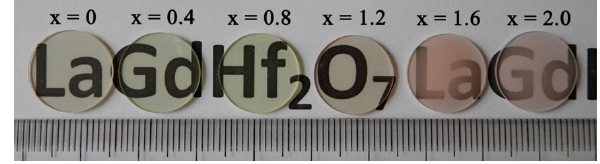
Fig. 12 Photograph of La 2– x Gd x Hf 2 O 7 transparent ceramics vacuum sintered at 1830 ℃ for 6 h and annealed at 1500 ℃ for 5 h in air (1 mm thick). Reproduced with permission from Ref. [44], © Elsevier B.V. 2015.